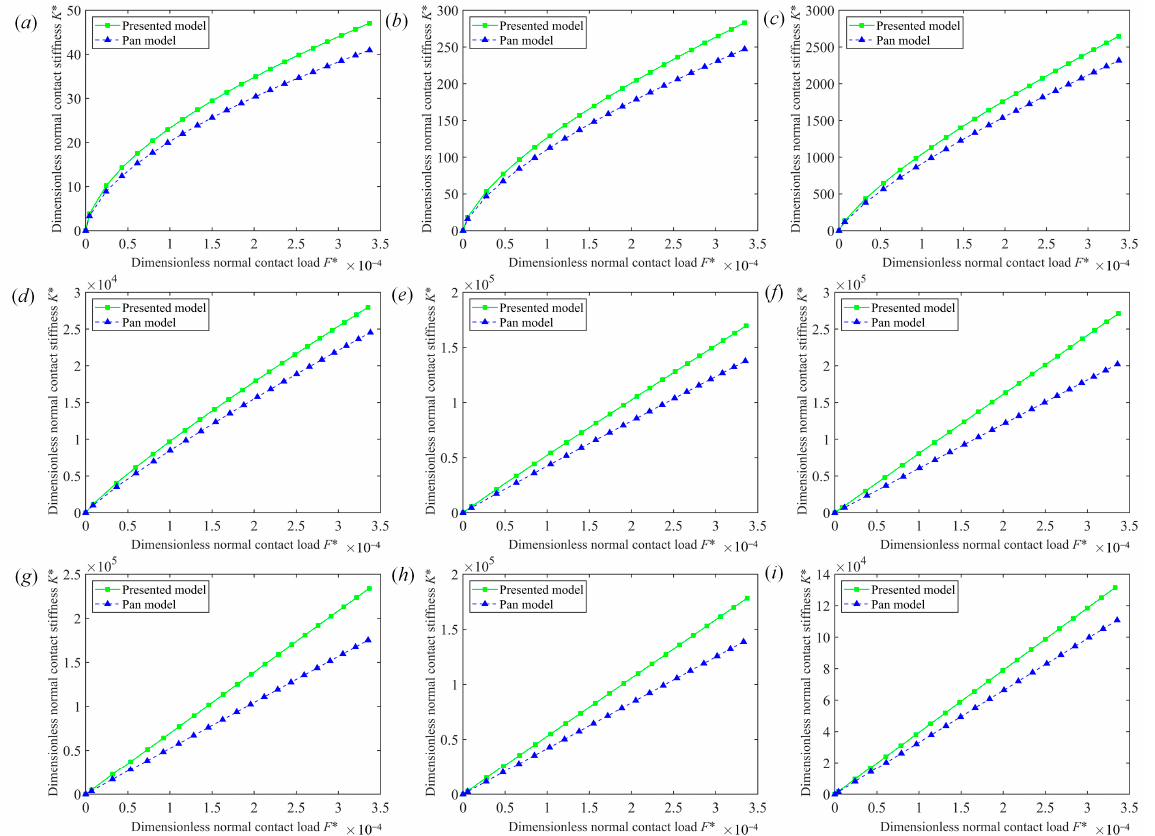
Figure 5. Comparison results between simulation results of the presented model and Pan model under different D : ( a ) D = 2.1; ( b ) D = 2.2; ( c ) D = 2.3; ( d ) D = 2.4; ( e ) D = 2.5; ( f ) D = 2.6; ( g ) D = 2.7; ( h ) D = 2.8; ( i ) D = 2.9.